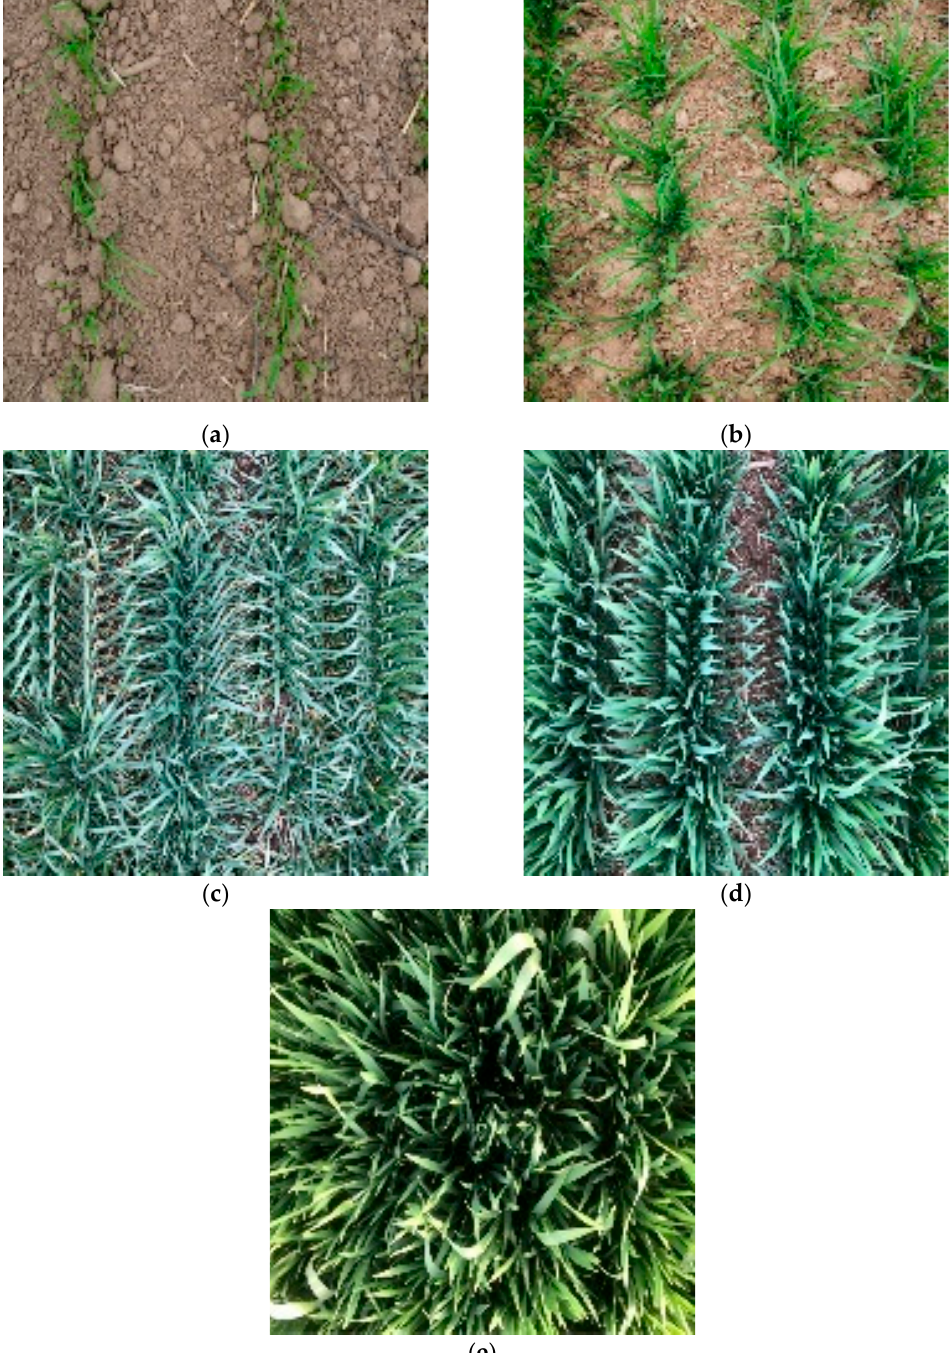
Figure 1. Wheat canopy images acquired in five stages: ( a ) seedling stage; ( b ) tillering stage; ( c ) overwintering stage; ( d ) greening stage; ( e ) jointing stage.